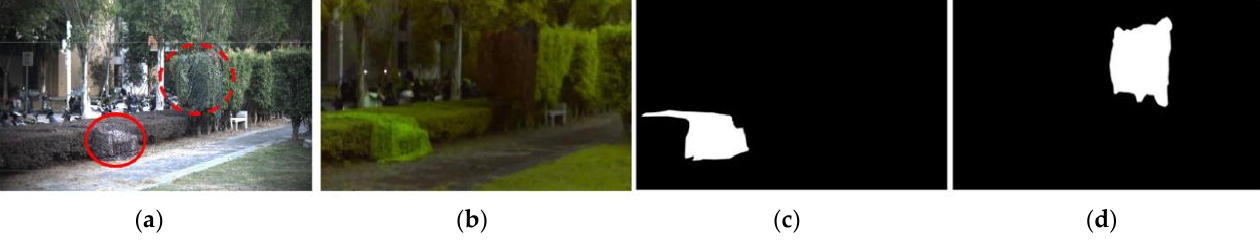
Figure 9. The quantitative comparison of AIRC-net detection results in the Lawn scene. ( a ) The curves of A C obtained using different methods; ( b ) The curves of F a obtained using different methods. ( c ) The histograms of F 1 obtained using different methods.